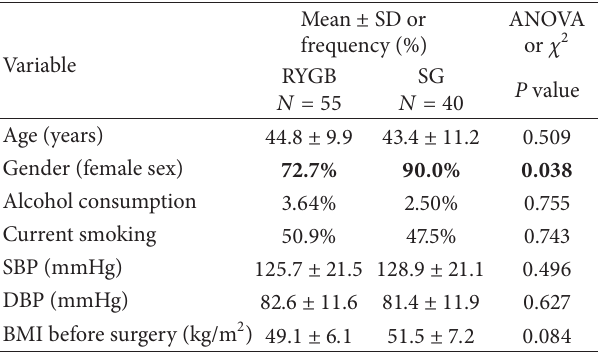
Table 1: Mean values of demographic, anthropometric, and bio- chemical characteristics of the sample at recruitment according to the type of